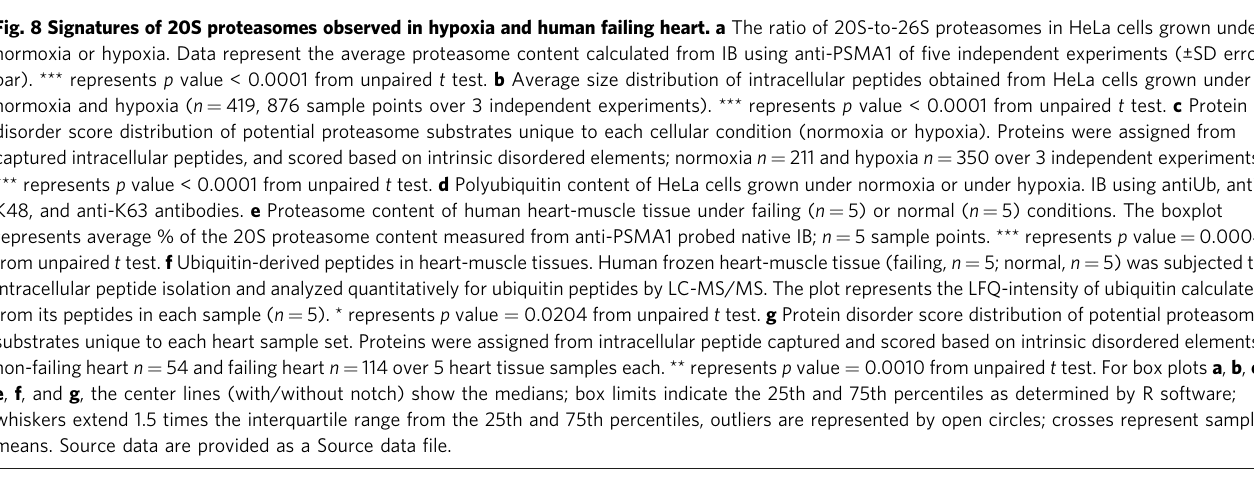
Fig. 8 Signatures of 20S proteasomes observed in hypoxia and human failing heart. a The ratio of 20S-to-26S proteasomes in HeLa cells grown under normoxia or hypoxia. Data represent the average proteasome content calculated from IB using anti-PSMA1 of fi ve independent experiments (±SD error bar). *** represents p value < 0.0001 from unpaired t test. b Average size distribution of intracellular peptides obtained from HeLa cells grown under normoxia and hypoxia ( n = 419, 876 sample points over 3 independent experiments). *** represents p value < 0.0001 from unpaired t test. c Protein disorder score distribution of potential proteasome substrates unique to each cellular condition (normoxia or hypoxia). Proteins were assigned from captured intracellular peptides, and scored based on intrinsic disordered elements; normoxia n = 211 and hypoxia n = 350 over 3 independent experiments. *** represents p value < 0.0001 from unpaired t test. d Polyubiquitin content of HeLa cells grown under normoxia or under hypoxia. IB using antiUb, anti- K48, and anti-K63 antibodies. e Proteasome content of human heart-muscle tissue under failing ( n = 5) or normal ( n = 5) conditions. The boxplot represents average % of the 20S proteasome content measured from anti-PSMA1 probed native IB; n = 5 sample points. *** represents p value = 0.0004 from unpaired t test. f Ubiquitin-derived peptides in heart-muscle tissues. Human frozen heart-muscle tissue (failing, n = 5; normal, n = 5) was subjected to intracellular peptide isolation and analyzed quantitatively for ubiquitin peptides by LC-MS/MS. The plot represents the LFQ-intensity of ubiquitin calculated from its peptides in each sample ( n = 5). * represents p value = 0.0204 from unpaired t test. g Protein disorder score distribution of potential proteasome substrates unique to each heart sample set. Proteins were assigned from intracellular peptide captured and scored based on intrinsic disordered elements; non-failing heart n = 54 and failing heart n = 114 over 5 heart tissue samples each. ** represents p value = 0.0010 from unpaired t test. For box plots a , b , c , e , f , and g , the center lines (with/without notch) show the medians; box limits indicate the 25th and 75th percentiles as determined by R software; whiskers extend 1.5 times the interquartile range from the 25th and 75th percentiles, outliers are represented by open circles; crosses represent sample means. Source data are provided as a Source data